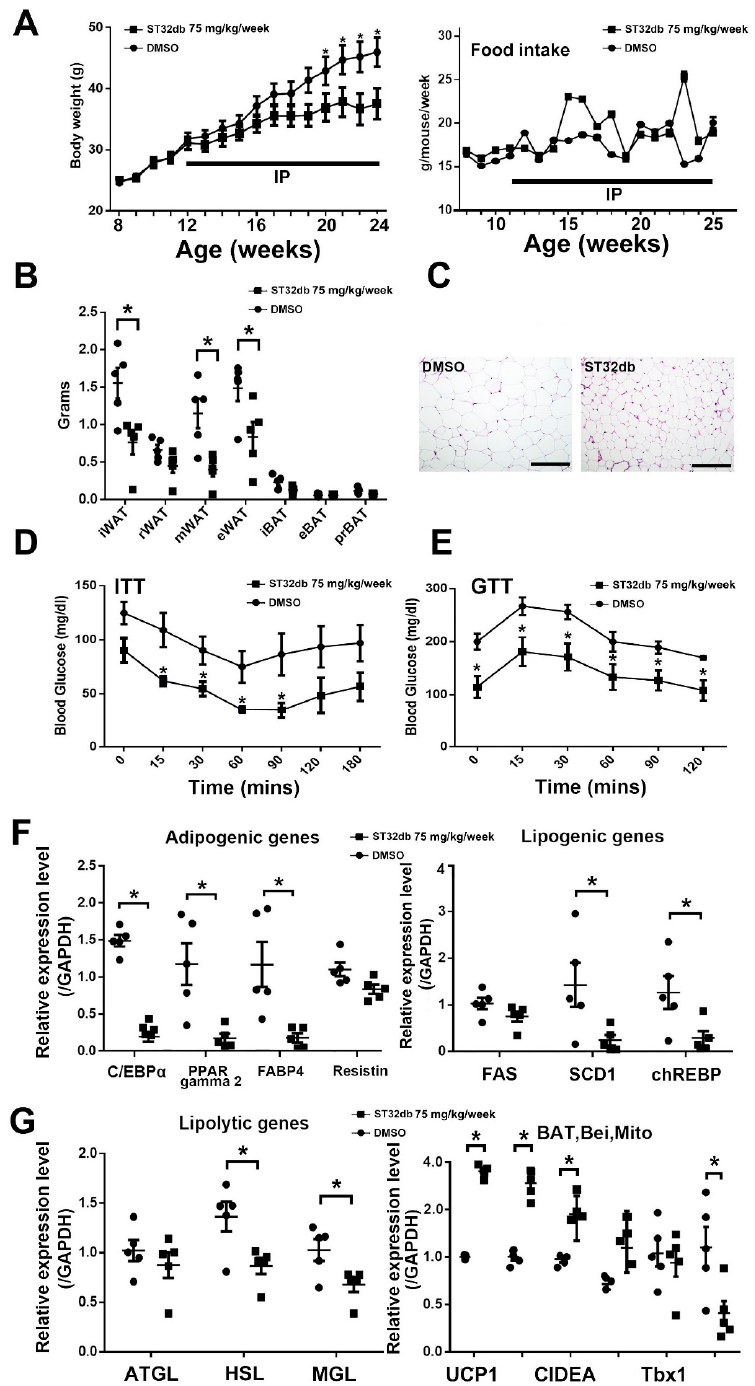
Figure 5. The ATF3 inducer ST32db prevents HFD-induced obesity and metabolic dysfunction. WT mice fed with an HFD for 12 weeks with or without intraperitoneal (i.p.) injection of ST32db at 75 mg/kg/week were analyzed. ( A ) Body weight and food intake. ( B ) Change in depot weight of BAT and WAT. ( C ) H&E staining results for iWAT with and without treatment. ( D ) Insulin tolerance test (ITT) results. ( E ) Glucose tolerance test (GTT) results. ( F ) Real-time PCR analysis results for mRNA levels of adipogenic, lipogenic, and lipolytic genes in iWAT. ( G ) Real-time PCR analysis results for mRNA levels of brown (BAT), beige (Bei), and mitochondria (Mito) genes in iWAT. Data are the mean ± SEM ( n = 5 per group); * p < 0.05 compared with control (DMSO). Scale bar = 100 µ